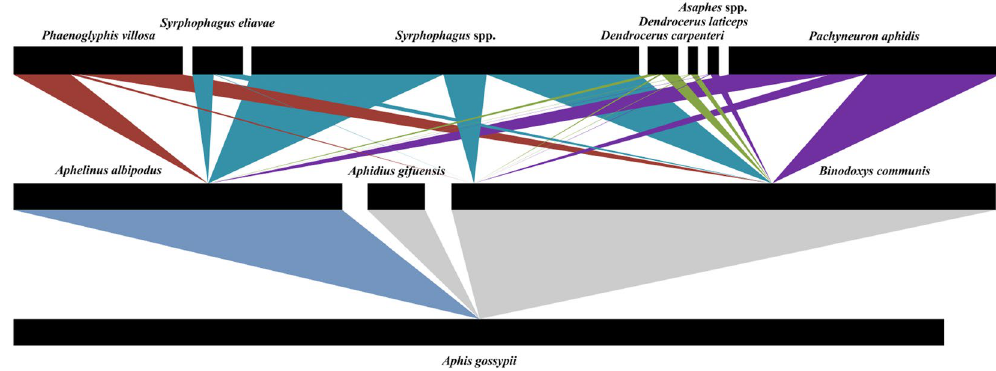
Figure 2. The tritrophic quantitative food web of aphids, parasitoids, and hyperparasitoids in cotton fields. The lower bars represent the aphid species; the middle bars represent the primary parasitoid species; and the upper bars represent the hyperparasitoid species. The links show the direct interactions between two species. The links for the hyperspecies from the same family have the same